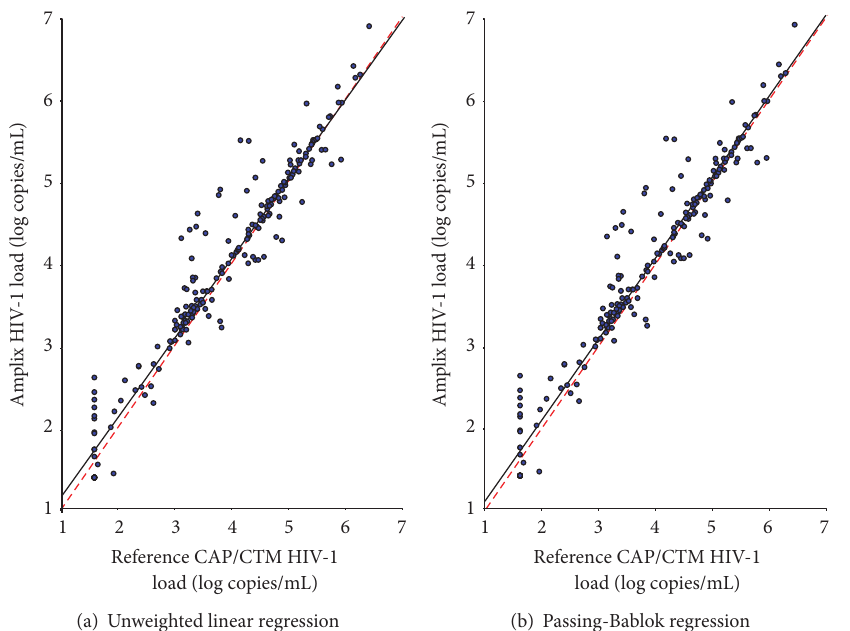
Figure 3: Unweighted linear regression (a) and Passing-Bablok regression (b) tests between plasma HIV-1 RNA viral load measurements in 215 HIV-1-infected adults, expressed in log copies/mL obtained in parallel by the HIV-1 RNA-based Amplix real-time PCR assay (Biosynex) and the reference COBAS (cid:2) AmpliPrep/COBAS TaqMan (CAP/CTM) HIV-1 test v2.0 (Roche Molecular Diagnostics). By unweighted linear regression, slope and Y-intercept values for the resultant trend line were 0.968 (95% CI, [0.933–1.002]) and 0.219 (95% CI, [0.080–0.357]), respectively. By Passing-Bablok regression, slope and 𝑌 -intercept values for the resultant trend line were 0.987 (95% CI, [0.968–1.009]) and 0.102 (95% CI, [0.009–0.186]), respectively. The diagonal dotted lines represent the ideal lines (no bias). The full lines represent the regression lines of the distribution. Table 3: Estimation of the accuracy of the HIV-1 RNA-based Amplix real-time PCR assay at nominal standards (20, 100, 1,000, 5,000,